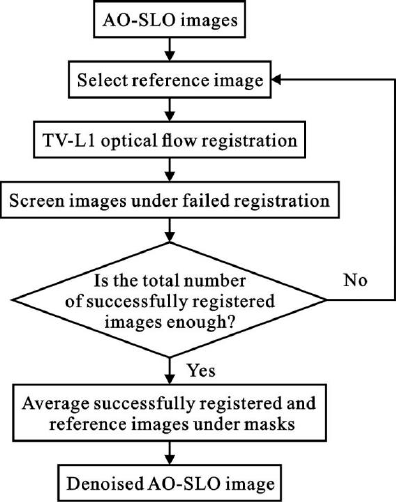
Figure 1. Flowchart of proposed method for automated cone cell identification.